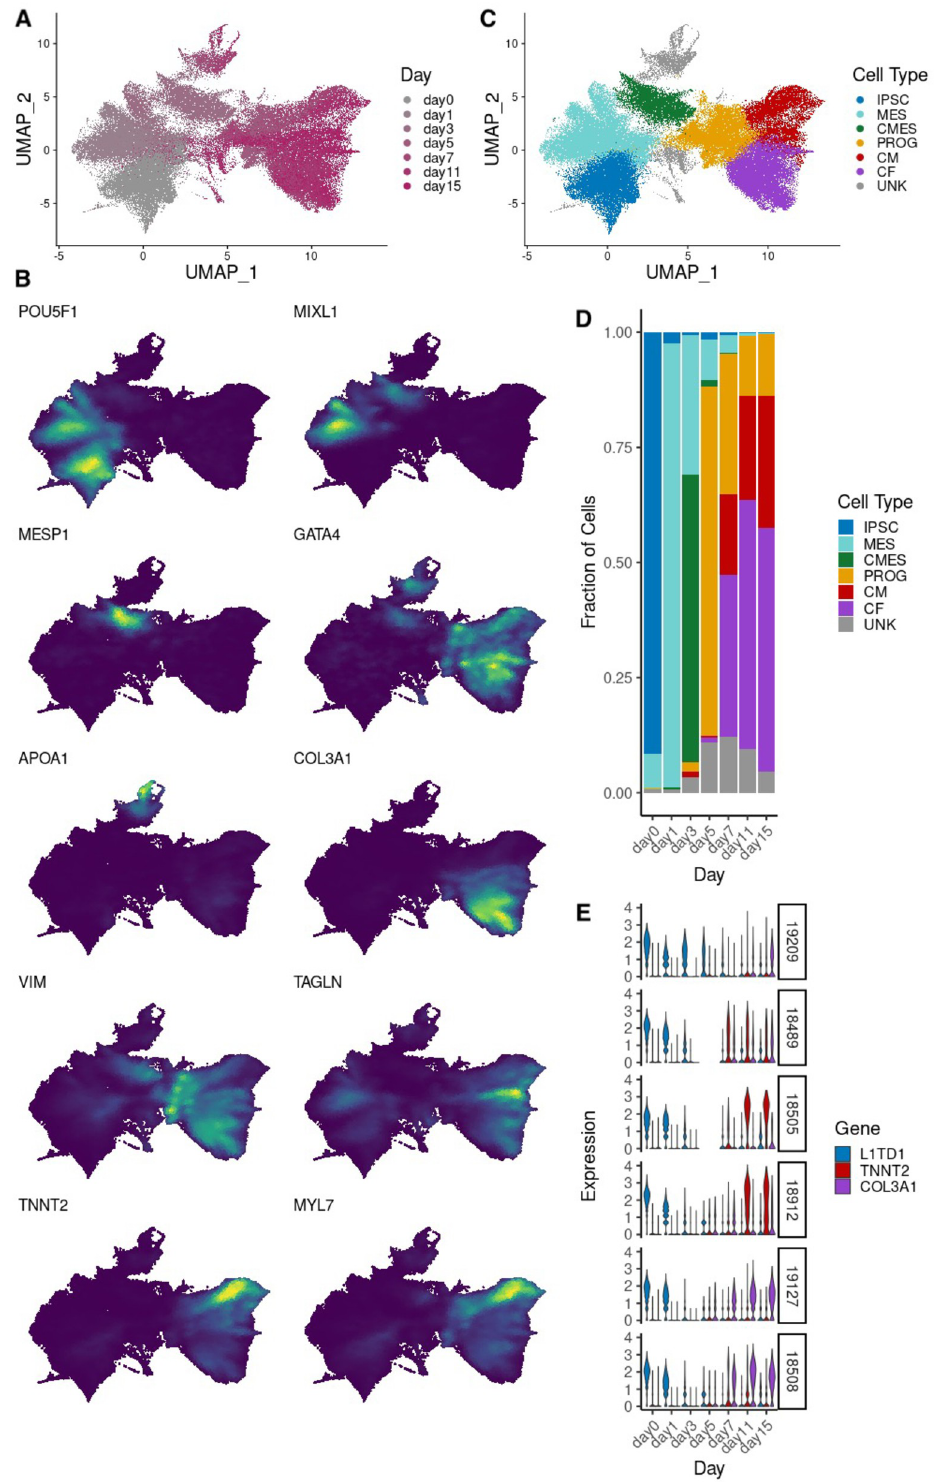
Fig 1. Gene expression patterns in single cell data. (A) UMAP of full single cell dataset; cells are colored by differentiation day. (B) Estimated density of expression for several marker genes across cells. (C) UMAP of full single cell dataset; cells are colored by cell type, assigned based on Leiden clustering and marker gene expression.